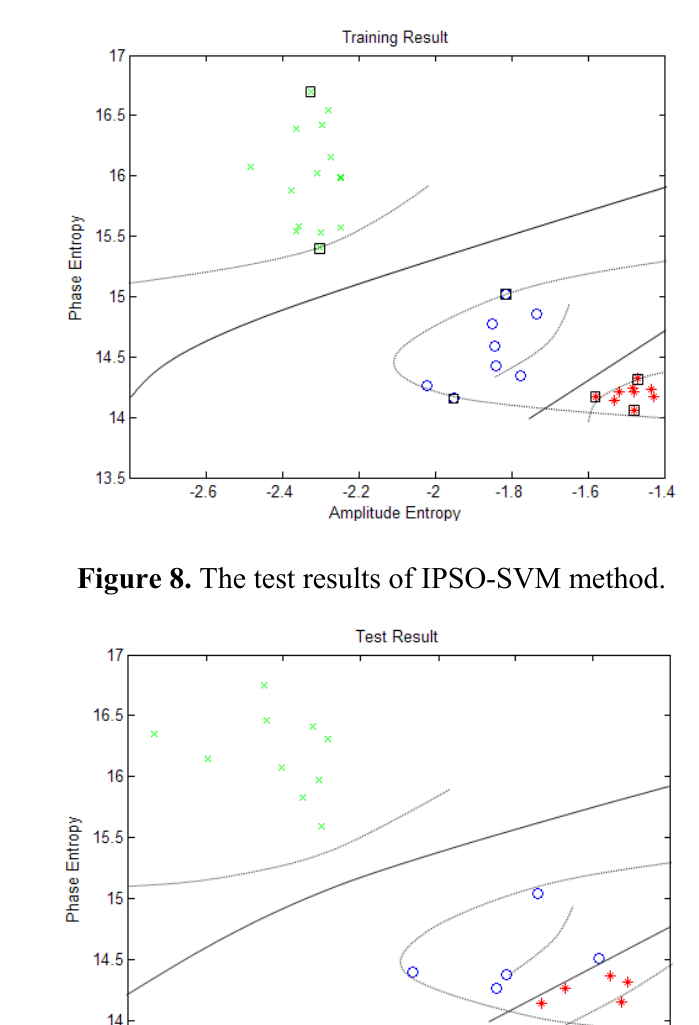
Figure 7. The training results of improved Particle Swarm Optimization-Support Vector machine (IPSO-SVM) method.